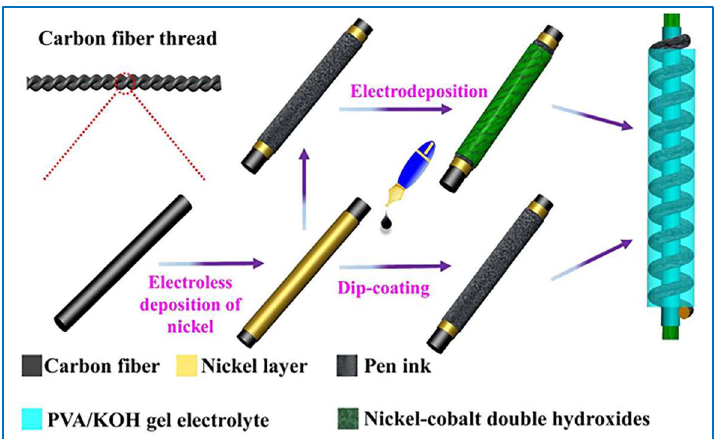
Figure 9. Schematic of preparation process of a flexible fiber-shaped supercapacitor by a combination of electroless deposition and dip-coating techniques [115].